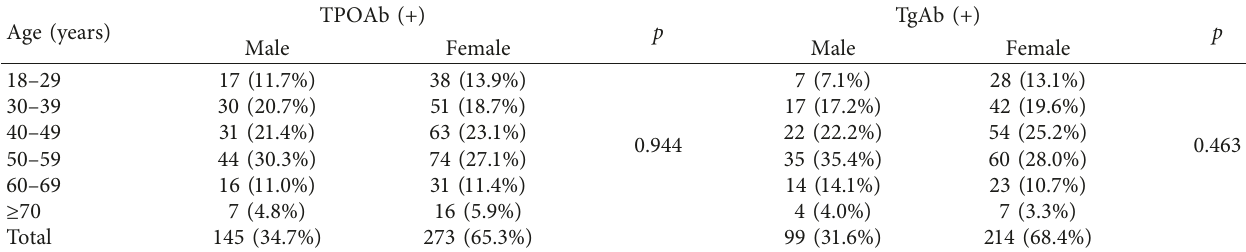
Table 6: Comparison of gender differences in autoantibody positive rates in different age groups.